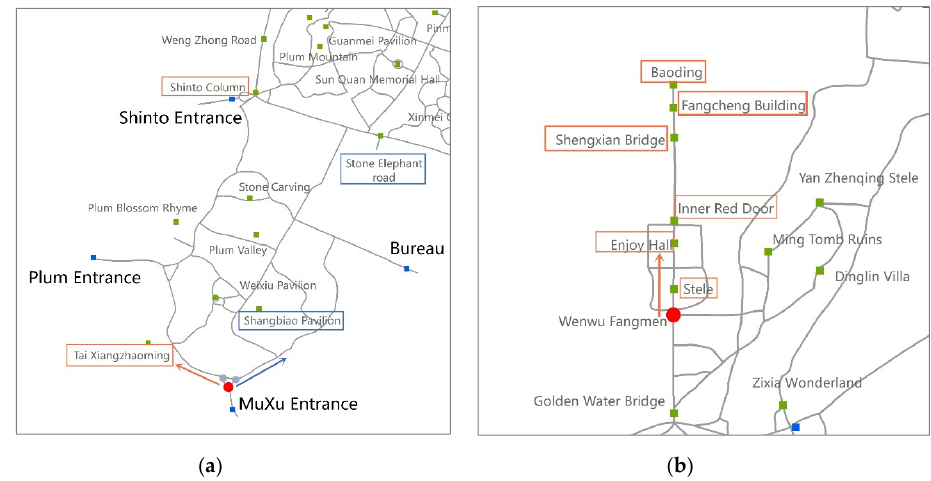
Figure 9. The representative example of display content in second and third type: ( a ) The result comes from multiple nodes; ( b ) the result is the edit after the check